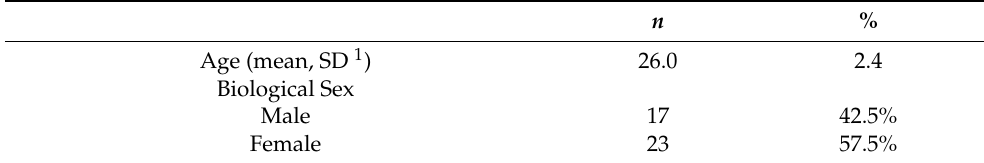
Table 2. Participant Characteristics ( n =